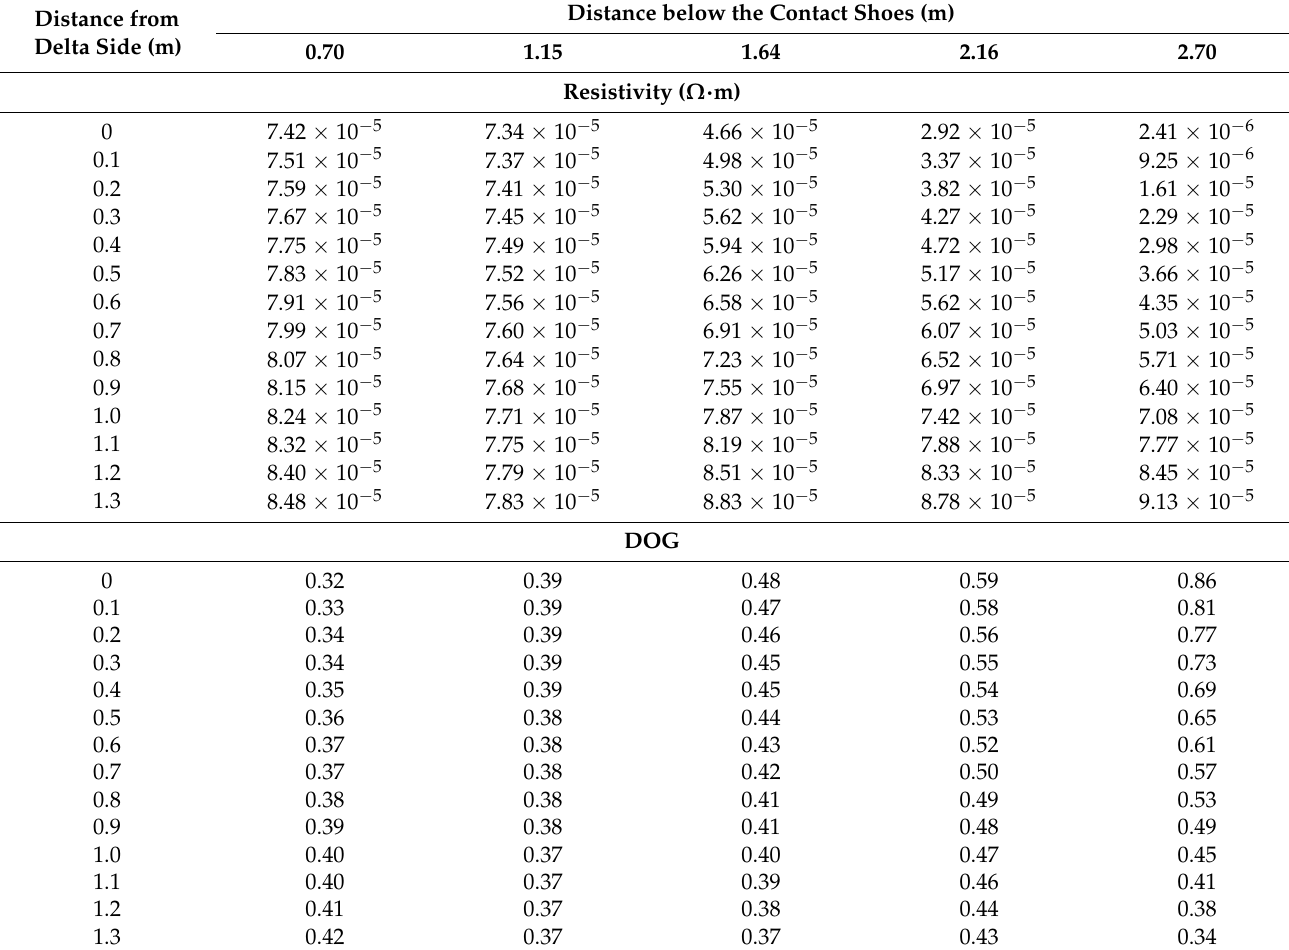
Table A1. The electrical resistivity, DOG, and bulk density data associated with the fitted lines in Figure 5a, Figure 6a, and Figure 7b, at 10 mm intervals across the diameter of the electrode at each of the investigated lengths below the contacts shoes, respectively. This data was spatially interpolated to generate the 3D images presented in Figure 5b, Figure 6b, and Figure 7c,